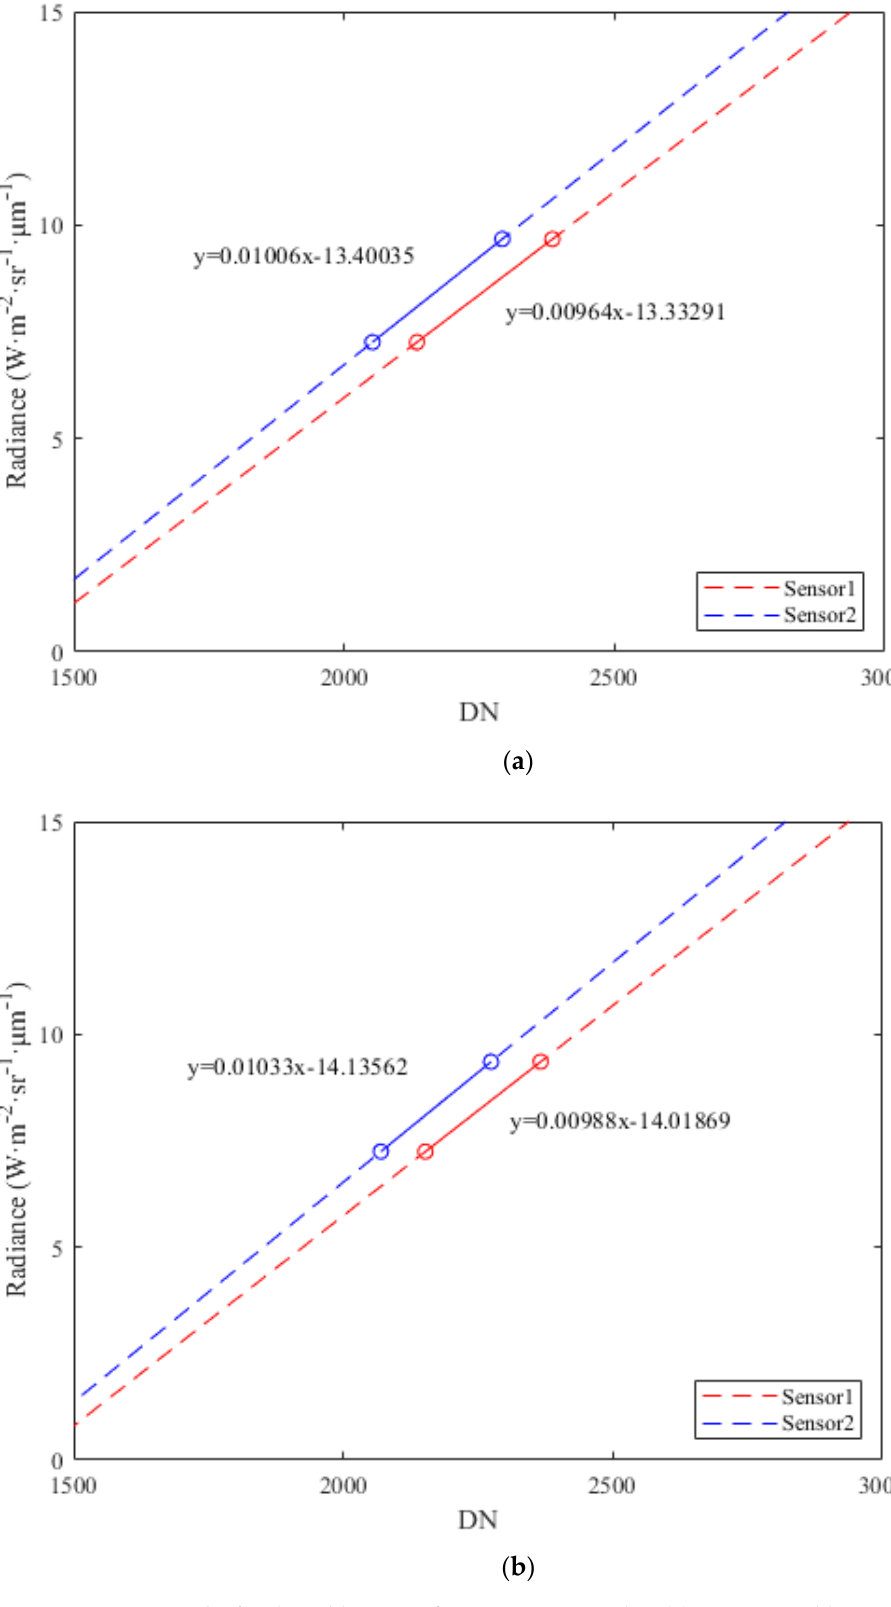
Figure 14. Fitting results for the calibration of ZY1-02E IRS in orbit: ( a ) 20220710 calibration coeffi- cients; ( b ) 20220713 calibration coefficients.